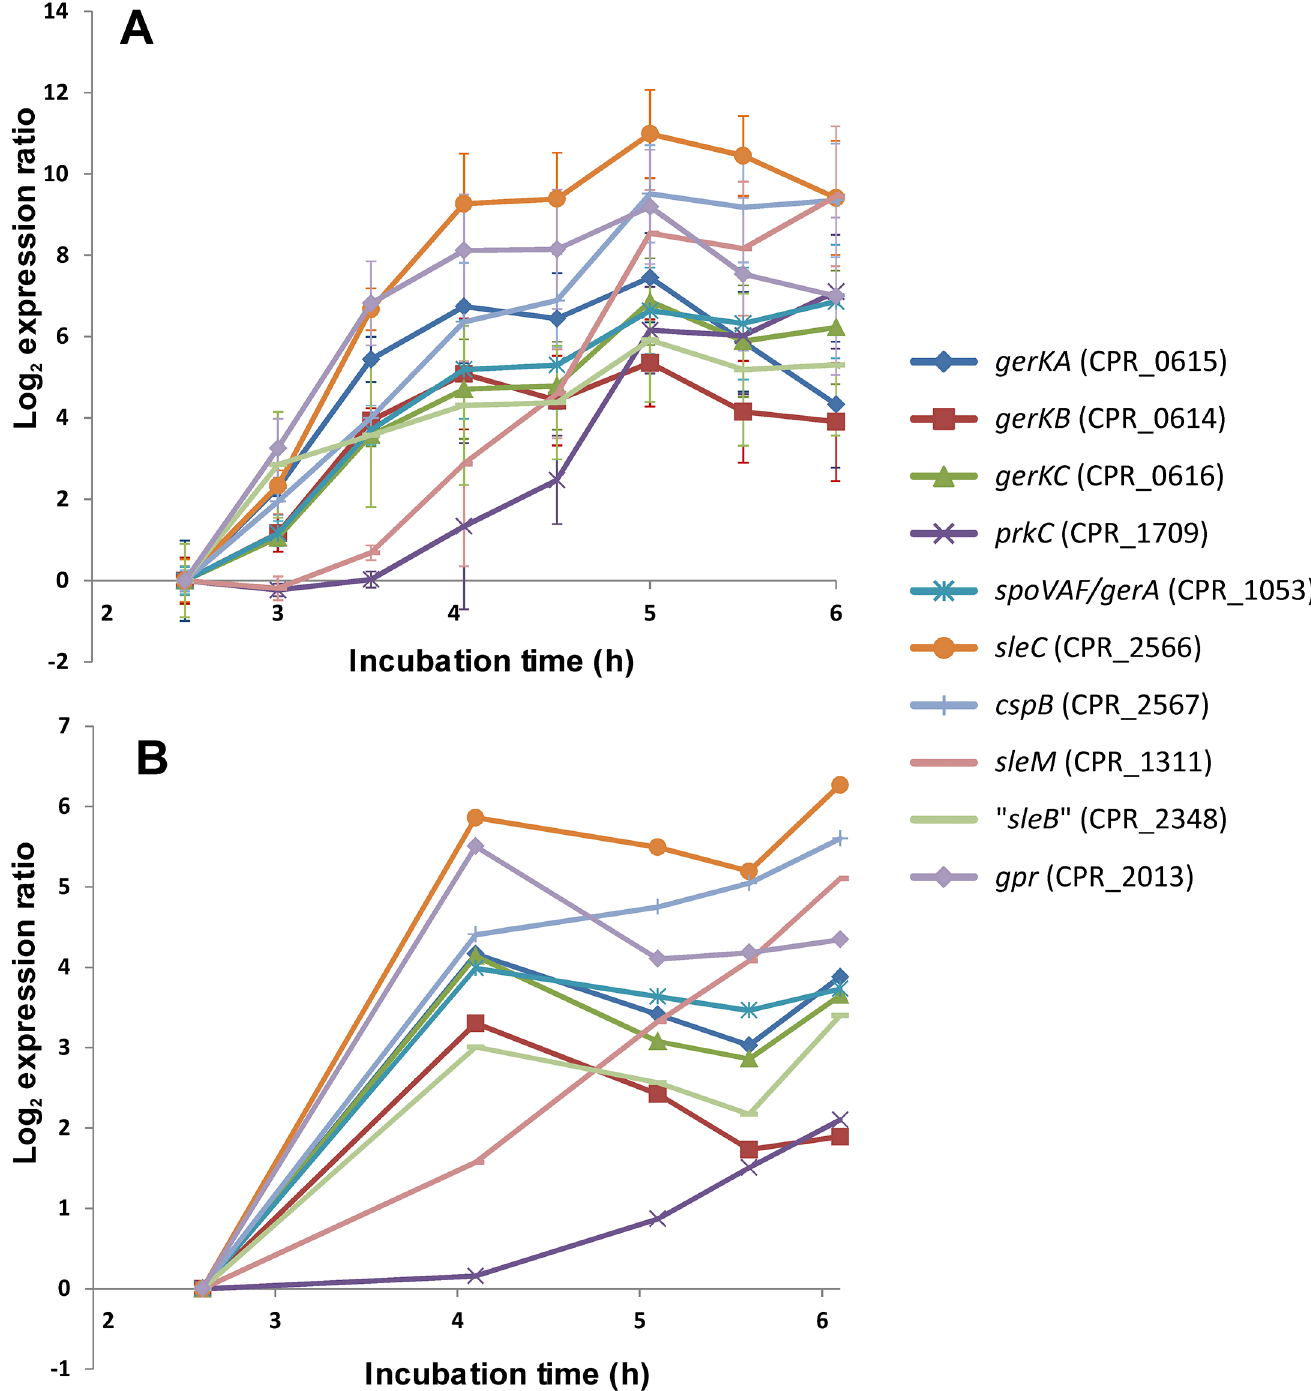
Fig 2. Time course expression of germination-related genes assessed by RT-PCR (A) and microarray analysis (B). Samples were taken from C . perfringens cultures growing in mDS (A) every 0.5 h after inoculation. Transcripts of genes dnaE and sigH were used to normalize Ct values resulting from RT-PCR. RNA from culture samples taken at the five representative time points was used for microarray expression profiling (B). The data extraction and presentation is described in the Materials and Methods section.